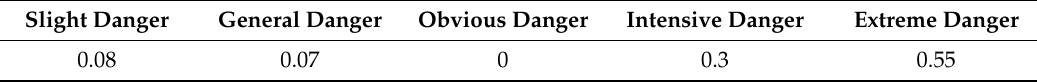
Table 7. The risk level of Santan